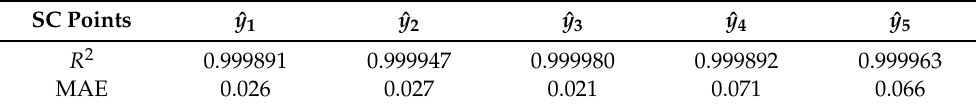
Figure 4. The goodness-of-fit on test dataset. Two scatter plots show the relation between the predicted values and the ground truth. Table 2. The approximation performance on test data